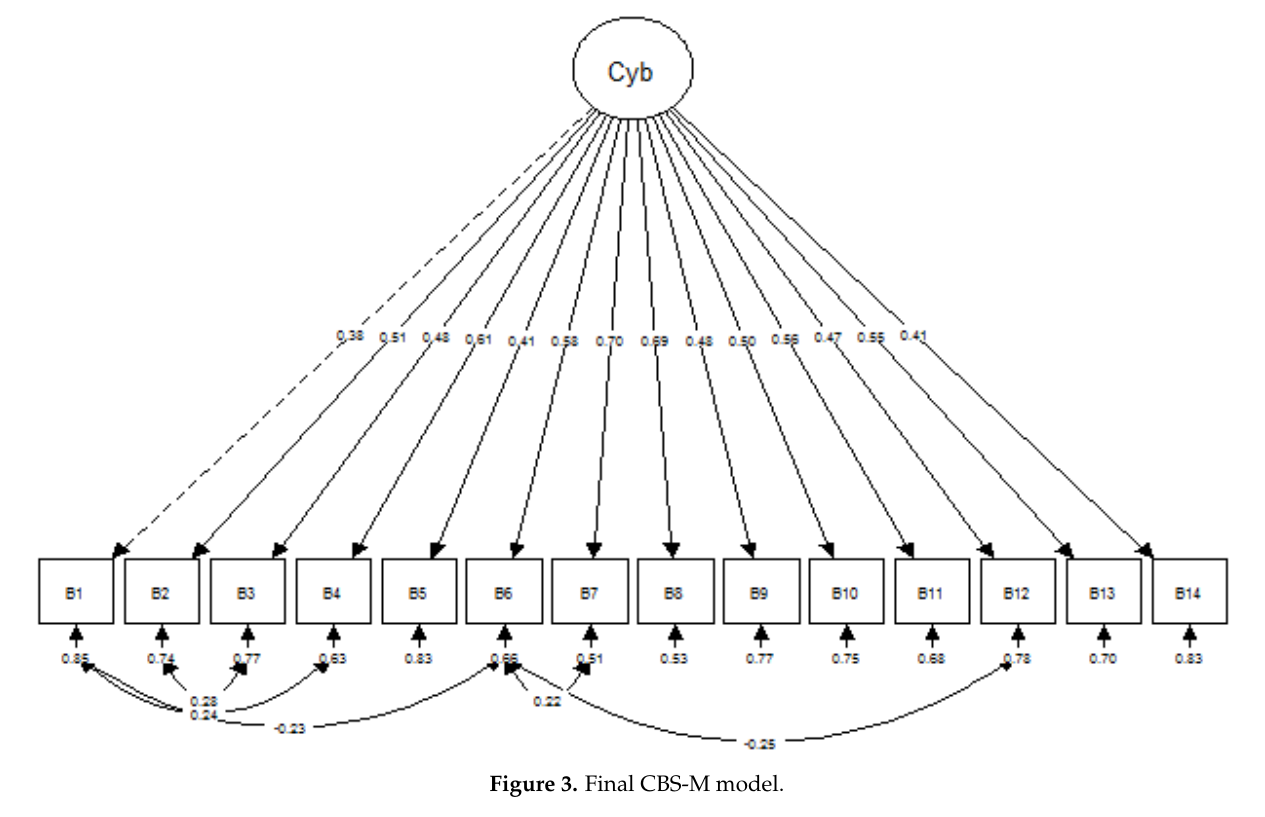
Figure 3. Final CBS-M model.